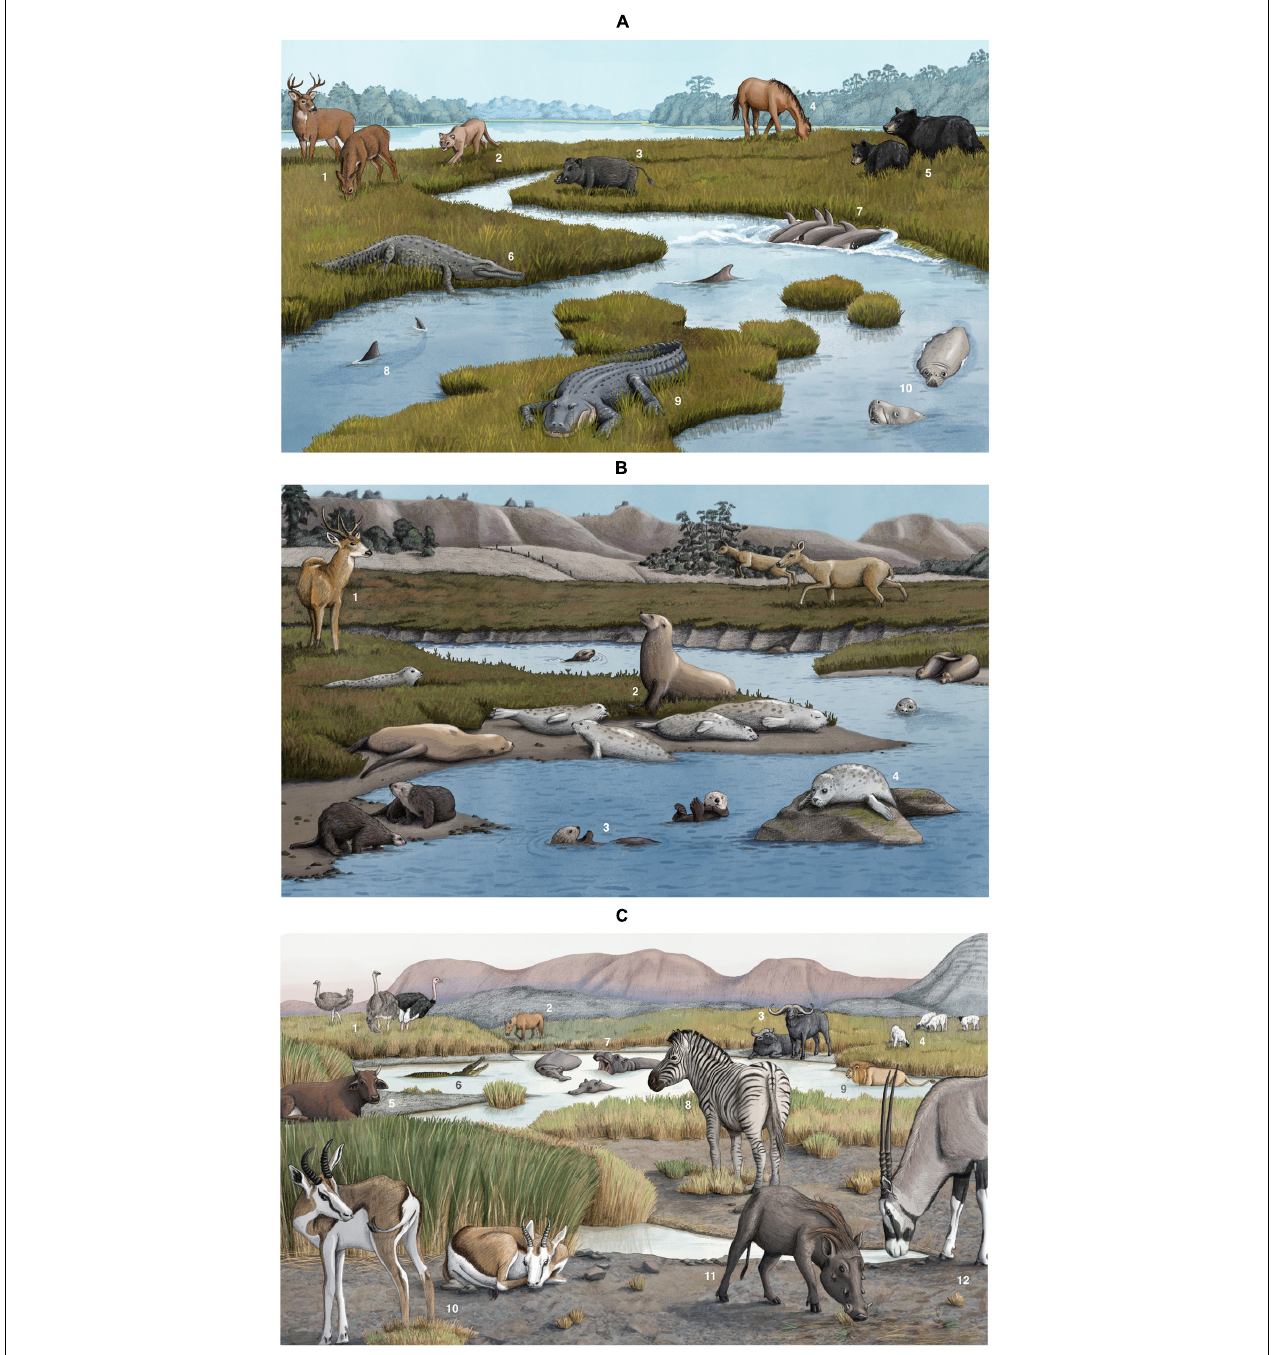
FIGURE 1 | (A) Megafauna in southeastern salt marshes including (1) white-tailed deer ( Odocoileus virginianus ), (2) Florida panther ( Puma concolor coryi ), (3) wild boar ( Sus scrofa ), (4) wild horse ( Equus ferus ), (5) black bear ( Ursus americanus ), (6) American crocodile ( Crocodylus acutus ), (7) bottlenose dolphin ( Tursiops truncatus ), (8) bull shark ( Carcharhinus leucas ), (9) American alligator ( Alligator mississippiensis ), and (10) west Indian manatee ( Trichechus manatus ). These are artistic illustrations and do not represent actual spacing among or abundance of megafauna. Artwork by Alex Boersma. (B) Megafauna in Elkhorn Slough, California salt marshes, including (1) mule deer ( Odocoileus hemionus ), (2) sea lions ( Zalophus californianus ), (3) sea otters ( Enhydra lutris ), and (4) harbor seals ( Phoca vitulina ). These are artistic illustrations and do not represent actual spacing among or abundance of megafauna. Artwork by Alex Boersma. (C) Megafauna in South African salt marshes, including (1) ostrich ( Struthio camelus ), (2) domesticated horse ( Equus ferus caballus ), (3) African buffalo ( Syncerus caffer ), (4) sheep ( Ovis aries ), (5) cattle ( Bos taurus ), (6) Nile crocodile ( Crocodylus niloticus ), (7) hippopotamus ( Hippopotamus amphibius ), (8) common zebra ( Equus quagga burchellii ), (9) lion ( Panthera leo ), (10) springbok ( Antidorcas marsupialis ), (11) common warthog ( Phacochoerus africanus ), (12) gemsbok ( Oryx gazella ). These are artistic illustrations and do not represent actual spacing among or abundance of megafauna. Artwork by Alex Boersma.